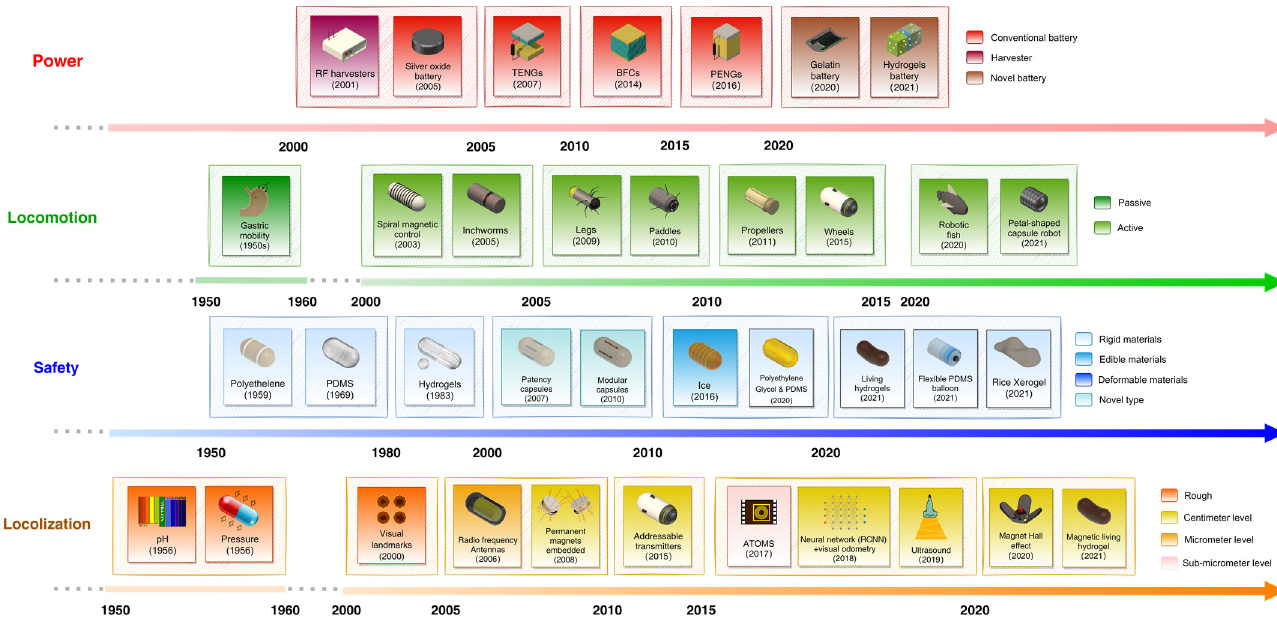
Figure 3. Scheme of IBCs design features: power [81–83], locomotion [84–86], localization [87–95], and safety [51,87,96–100] and levels of development over time. (Created with BioRender.com). and safety [51,87,96–100] and levels of development over time. (Created with